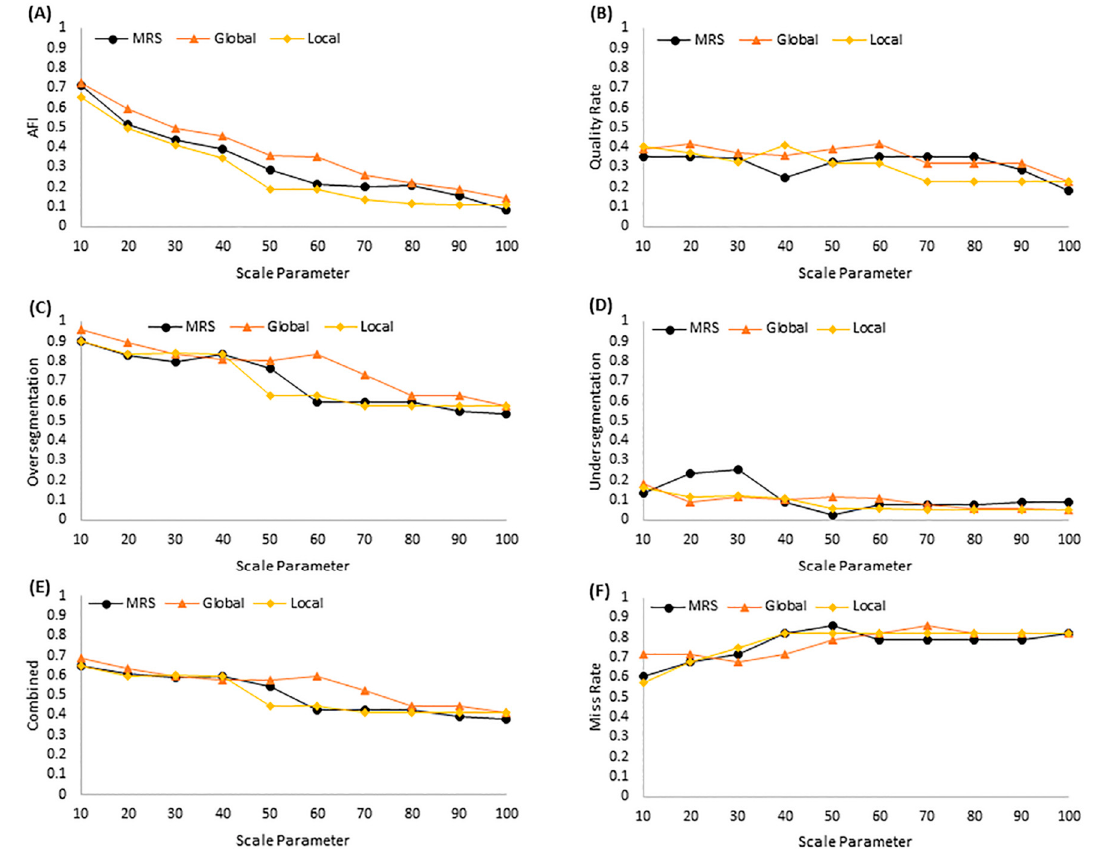
Figure 5. The performance of the three segmentation methods according to the three-band average ( A ) weighted variance ( wVar ) and ( B ) Moran’s I values.